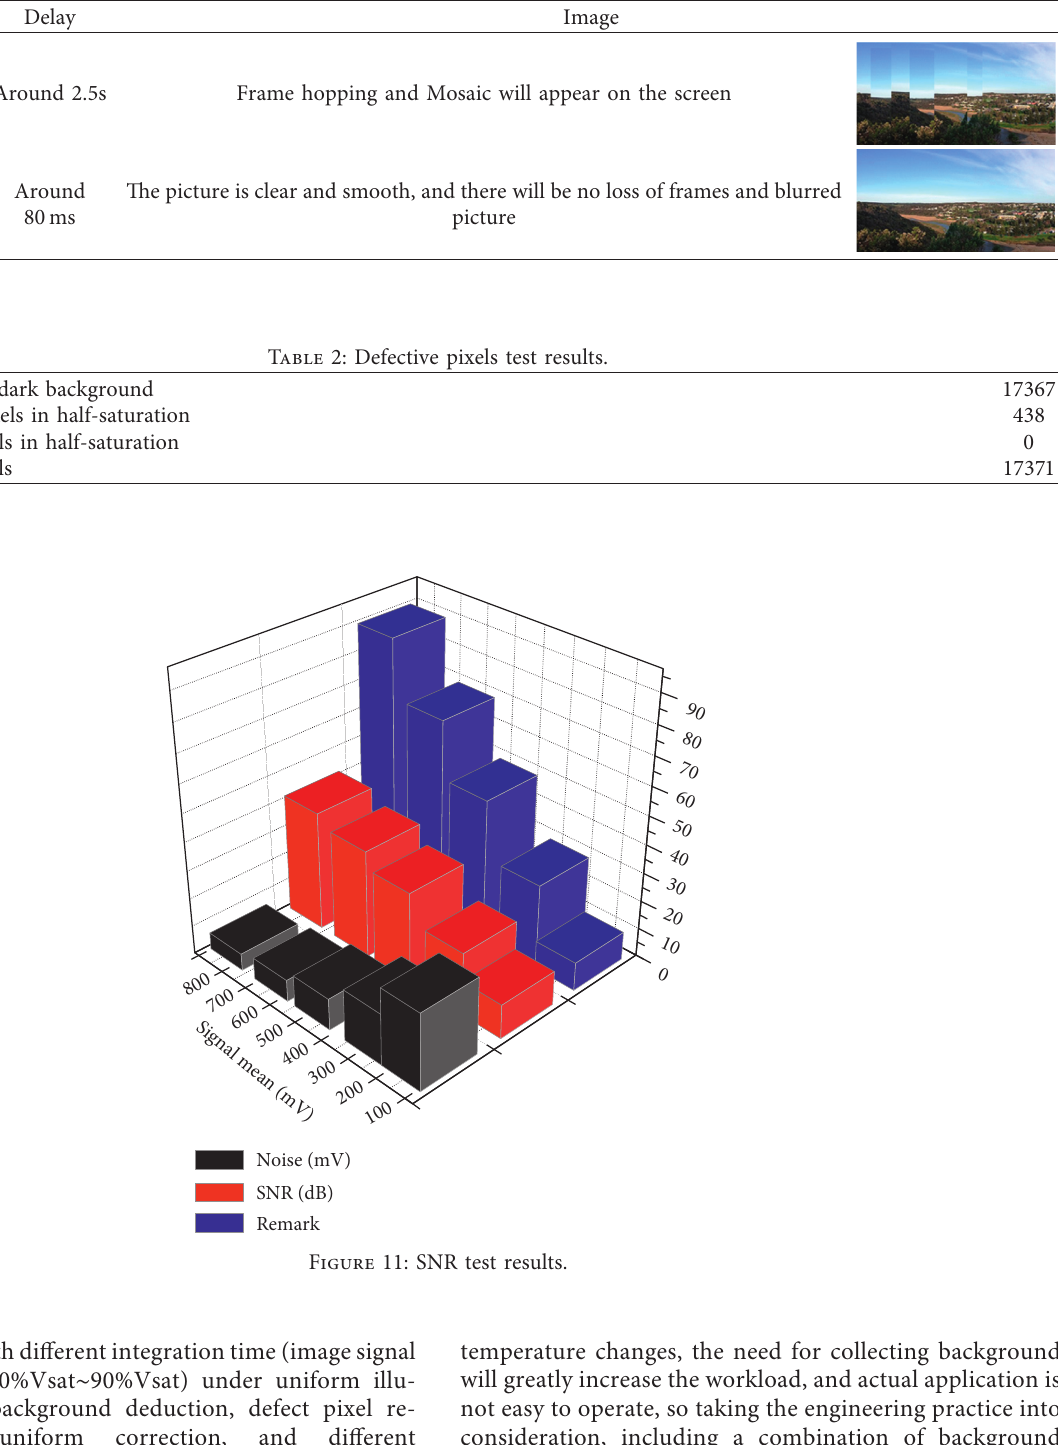
Table 1: Results of an effect test based on RTCP feedback congestion